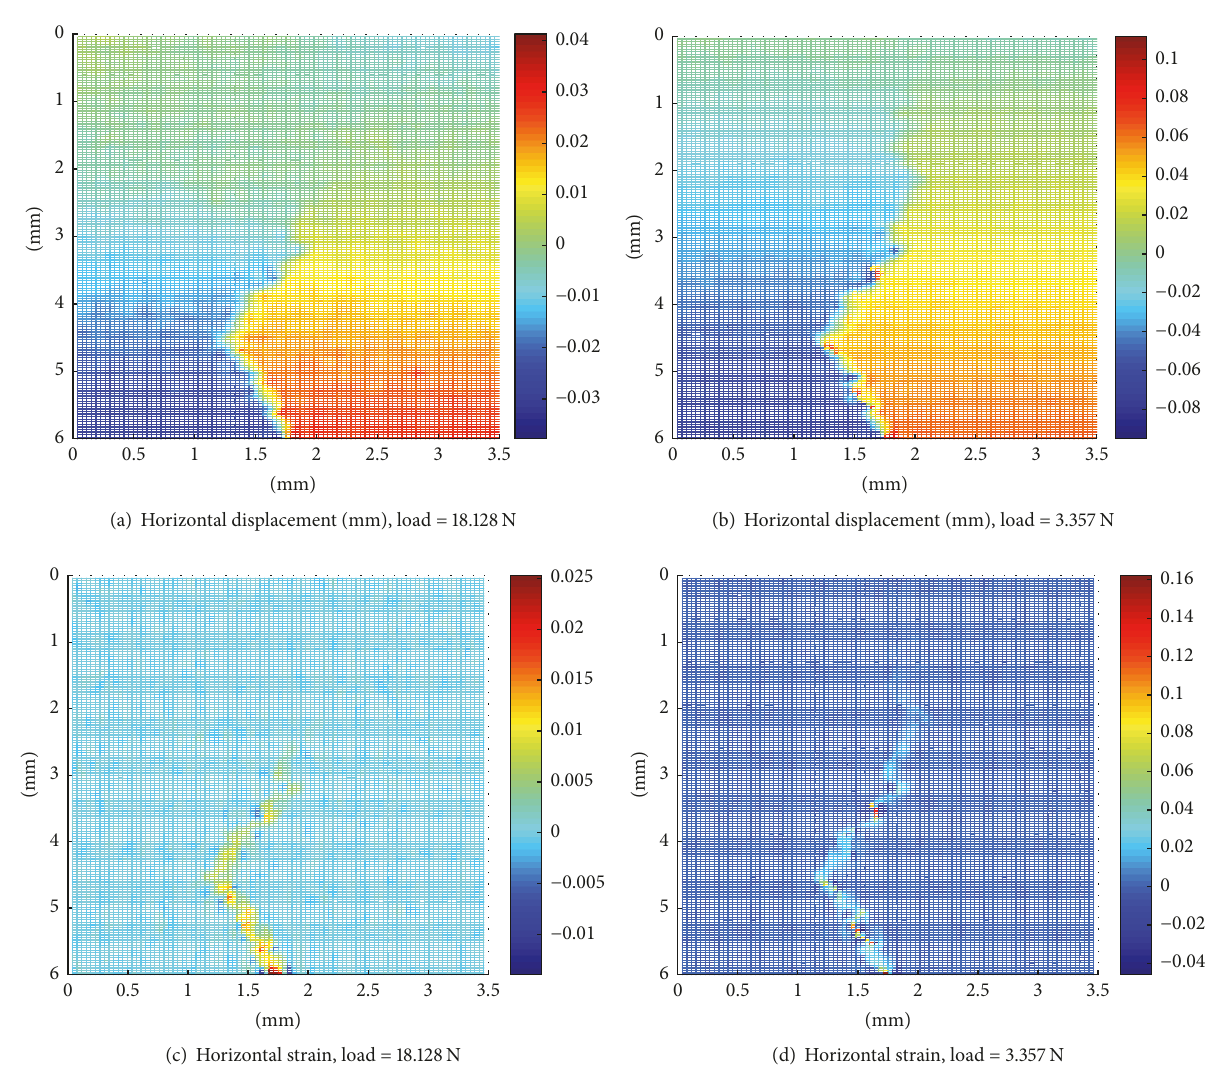
Figure 2: Strain and displacement fields from DIC analysis under different postpeak